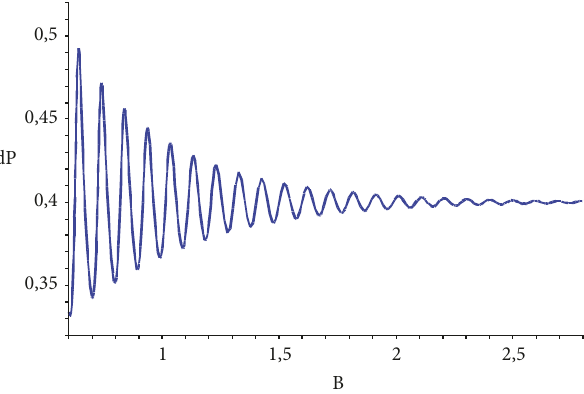
Figure 6: Shubnikov-de Haas oscillations in samples HgSe at T = 2.7 K, calculated using formula